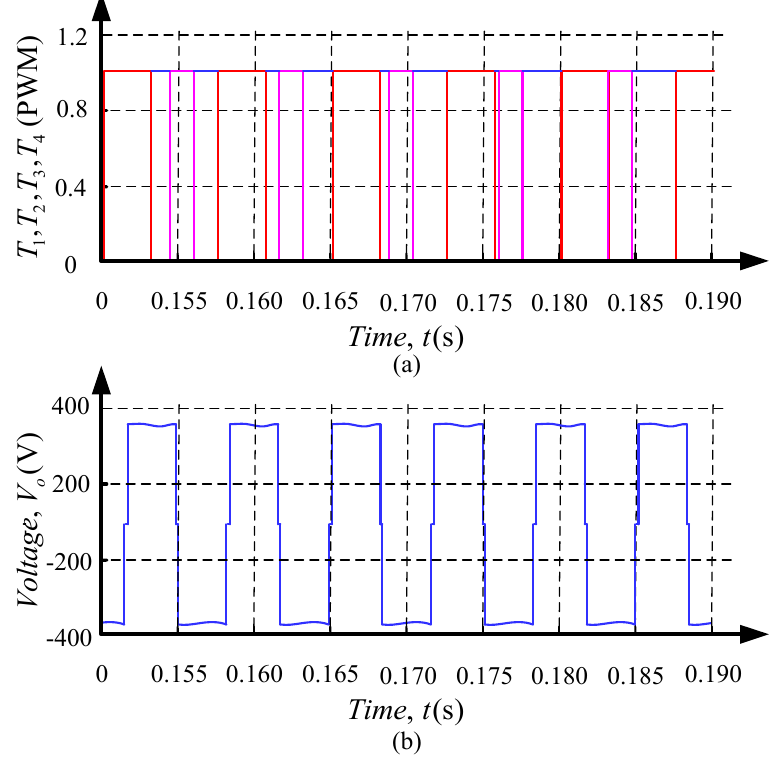
Figure 14. Output: ( a ) Inverter fuzzy logic PWM; ( b ) output voltage before filter.